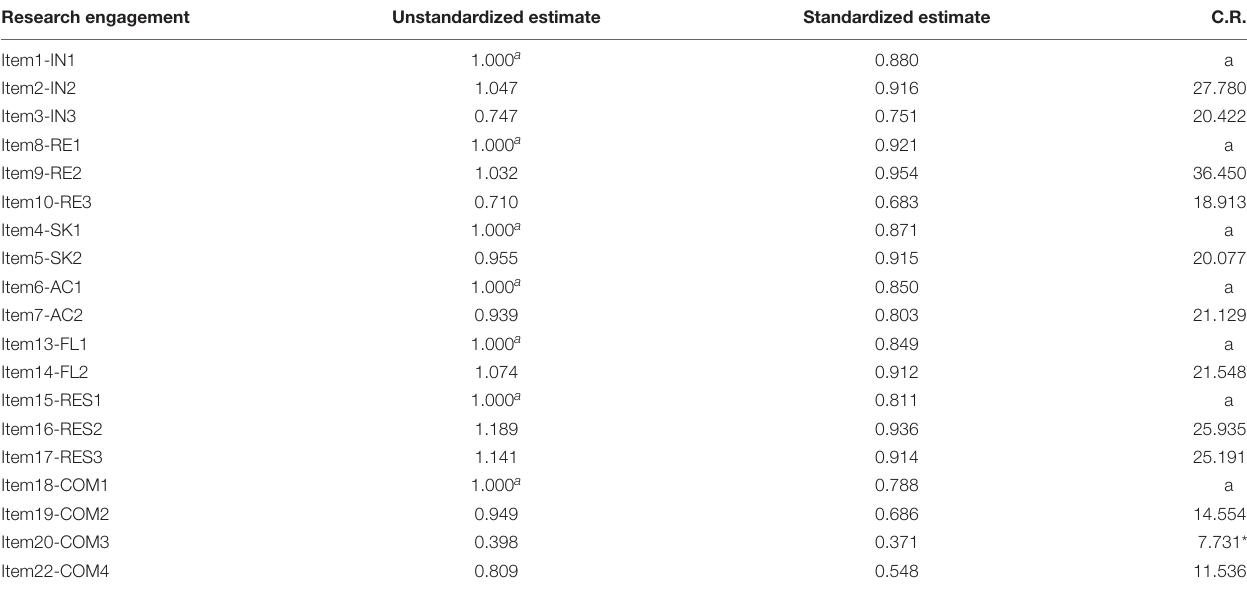
TABLE 10 | CFA regression weights for the seven-factor correlated model of research motivation.